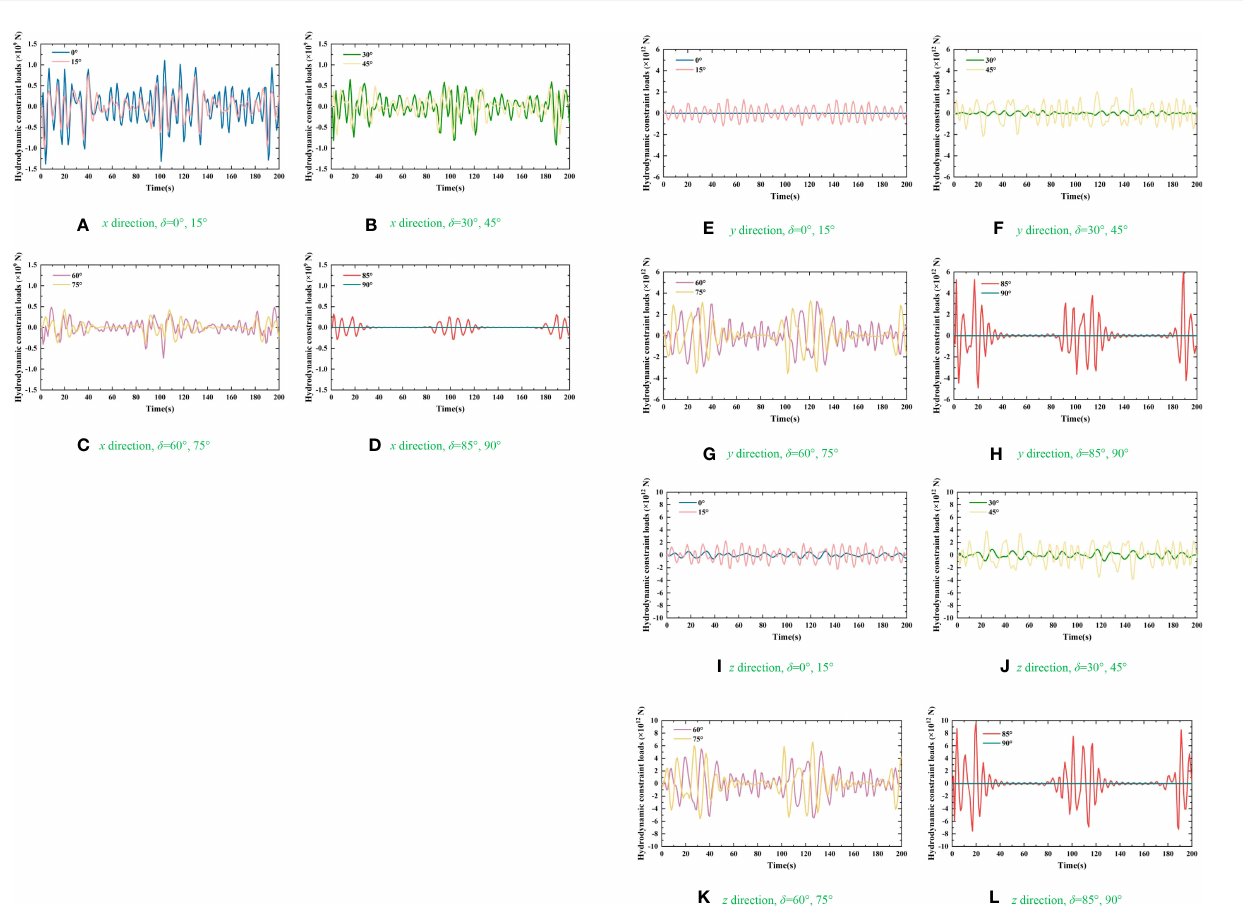
FIGURE 15 Time-domain hydrodynamic constraint loads of C 3 : (A) x direction, d =0°, 15°; (B) x direction, d =30°, 45°; (C) x direction, d =60°, 75°; (D) x direction, d =85°, 90°; (E) y direction, d =0°, 15°; (F) y direction, d =30°, 45°; (G) y direction, d =60°, 75°; (H) y direction, d =85°, 90°; (I) z direction, d =0°, 15°; (J) z